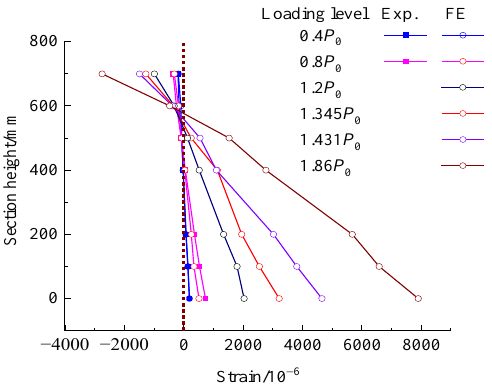
Figure 13. Concrete strain at mid-span section of the strengthened beam at different loading level.